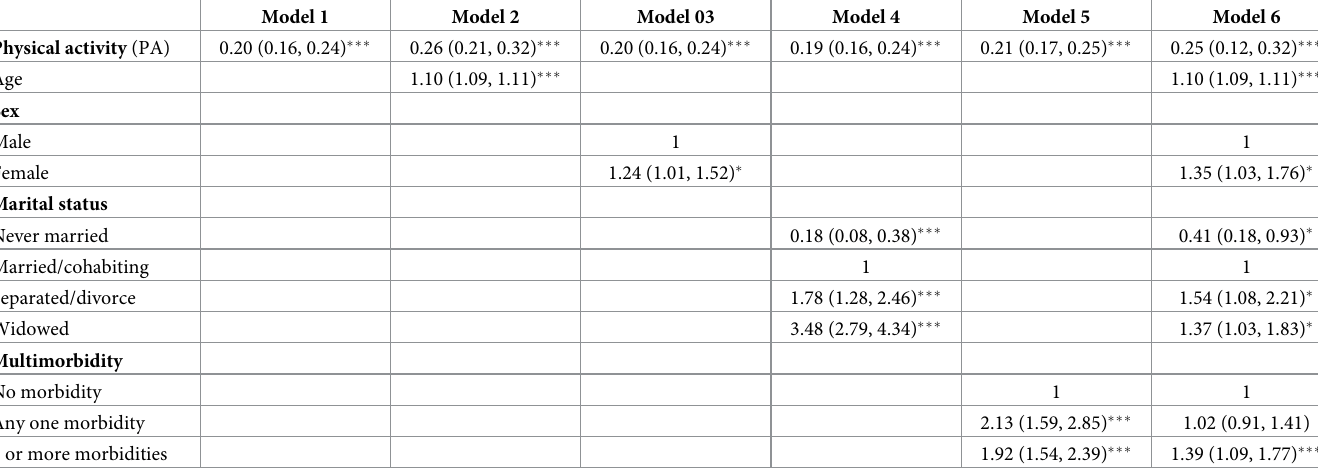
Table 2. Relationship between physical activity and functional disability adjusted for